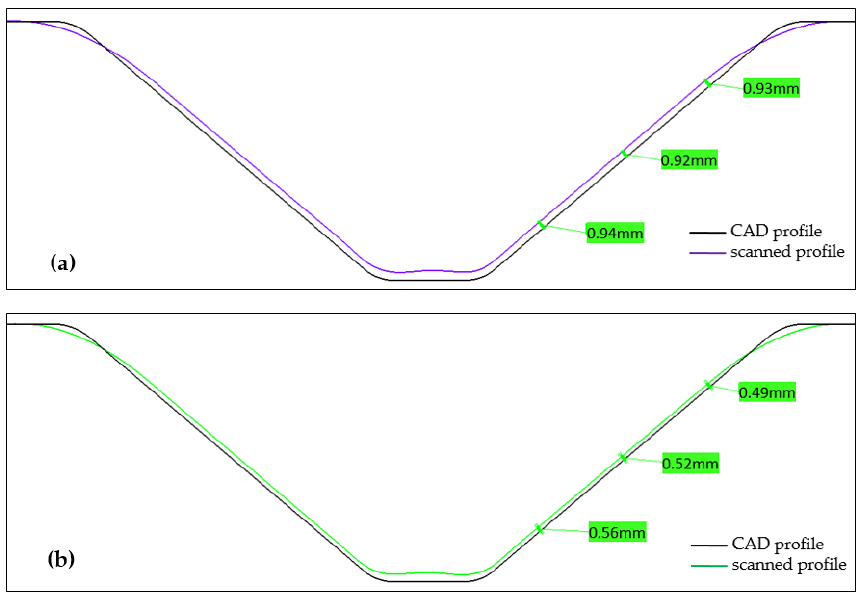
Figure 13. Comparison of deviations measured on a D 95 H 35 α 40 ∆ z 0.5 part, reprinted with permission from ref. [5]: ( a ) profile of a part machined with a CT; ( b ) profile of a part machined with a CHT.